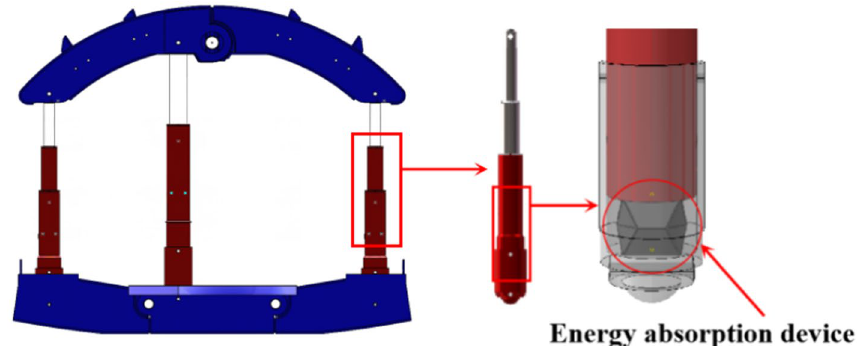
Figure 2. Location of the energy absorbing device in the structure.